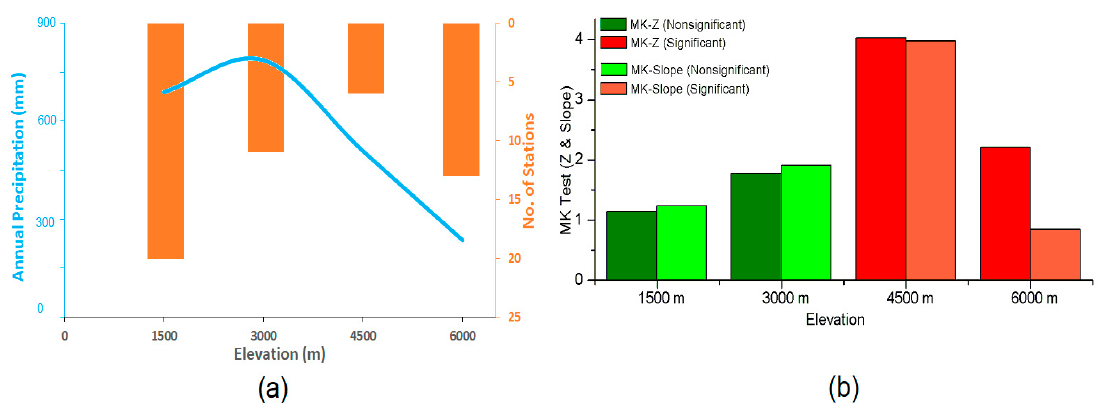
Figure 6. ( a ) Elevation-dependent precipitation, ( b ) trends and slope of precipitation at different